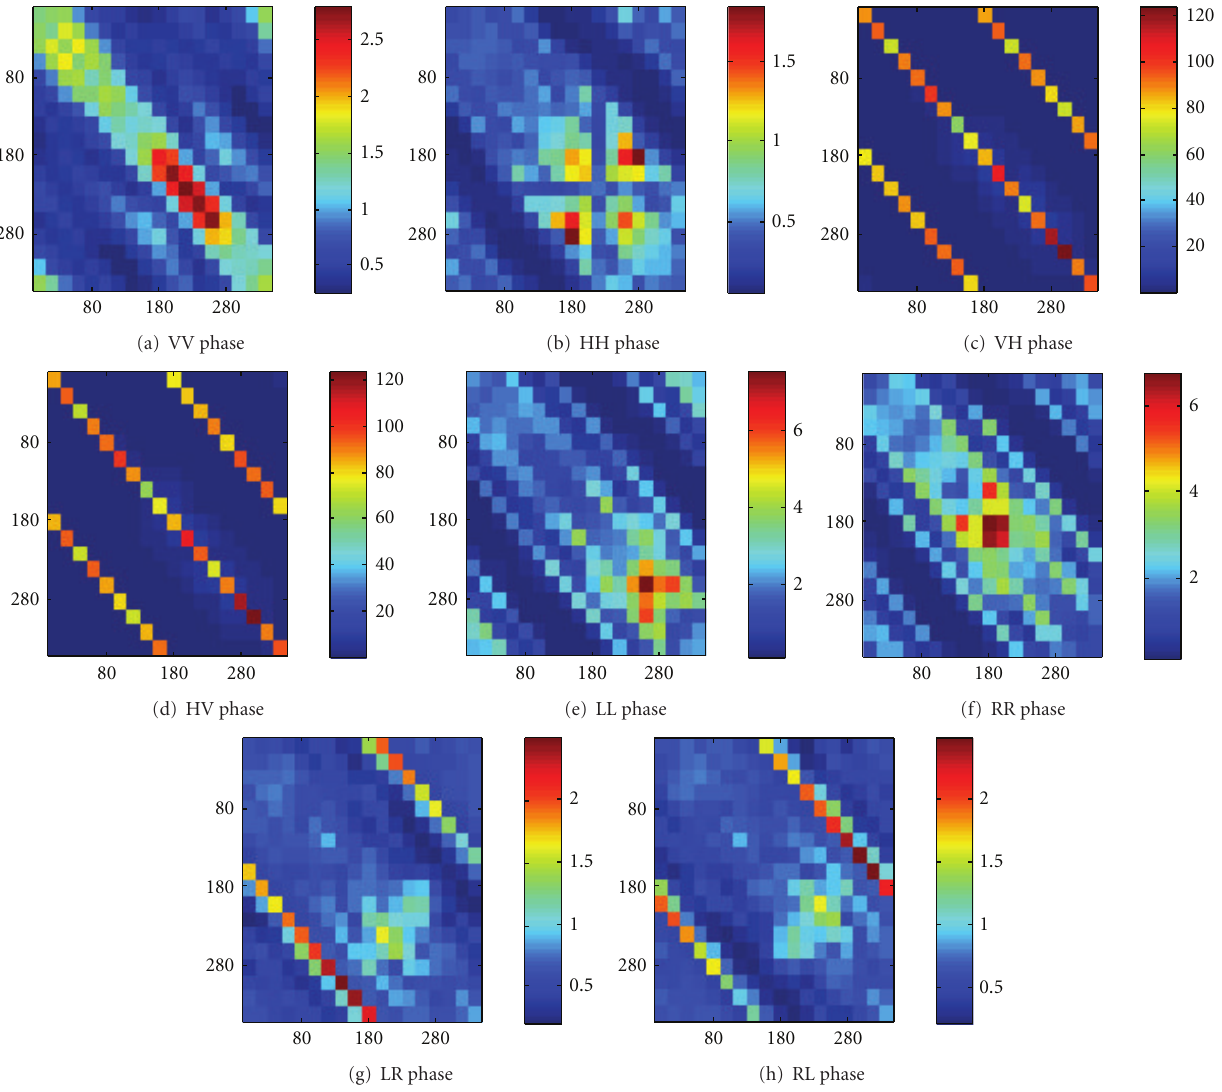
Figure 7: MD AB ,phase for di ff erent transmitter/receiver combinations. The comparison is made between the reference data (no tumor) with the case with 5mm tumor with the dielectric properties given in Figure 3(b). (a) VV, (b) HH, (c) HV, (d)VH, (e) LL, (f) RR, (g) RL and (h) LR. The vertical axis corresponds to the aspects of the incidence ( ϕ t = 0 ◦ to 340 ◦ ) and the horizontal axis corresponds to the aspects of the scattered far-field ( ϕ r = 0 ◦ to 340 ◦